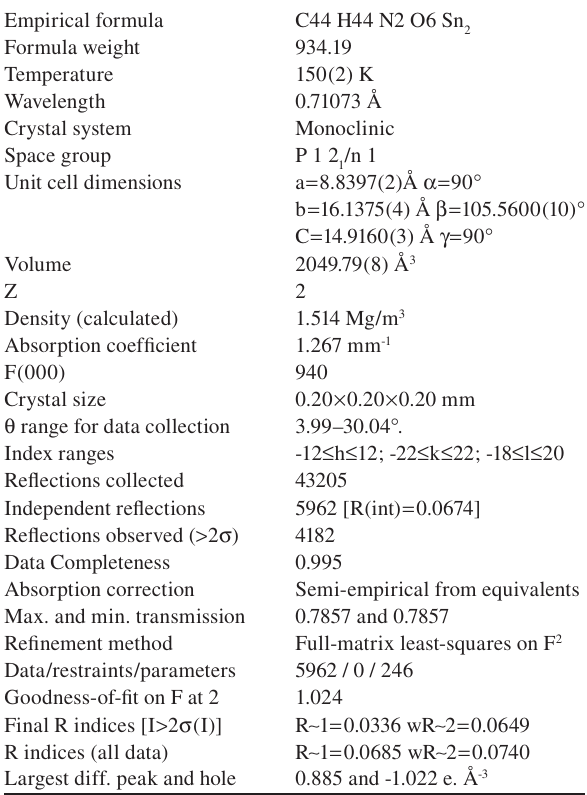
Table 1 Crystal data of the title